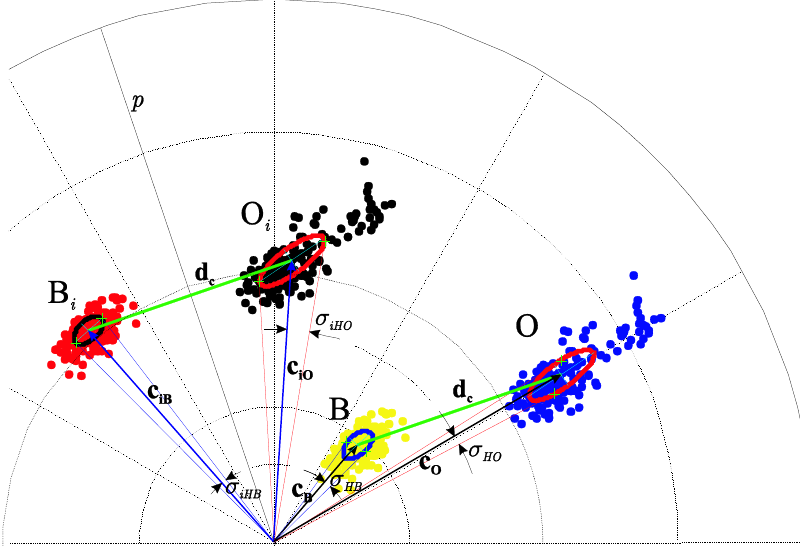
Figure 5. Uncertainty ellipses of the classes O and B in the C injection: O (blue) and B (yellow) and after the colour injection: O (black) and B (red). Geometric approximation of the hue deviations of the classes, as a function of the ellipse locations. The different alignments of the axes of the ellipse with respect to the direction of the mean vectors of each class are